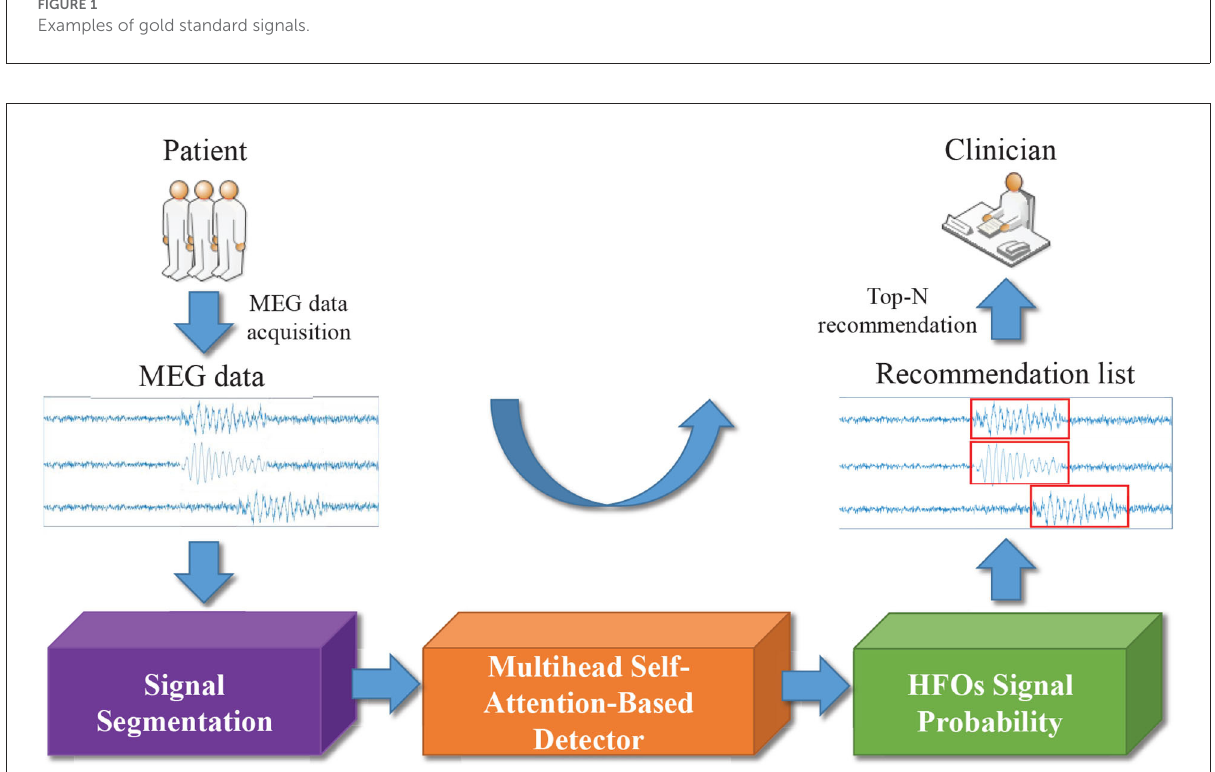
FIGURE2 Overview of multi-head self-attention based detector for recommendation of neuromagnetic high frequency oscillations in epilepsy.